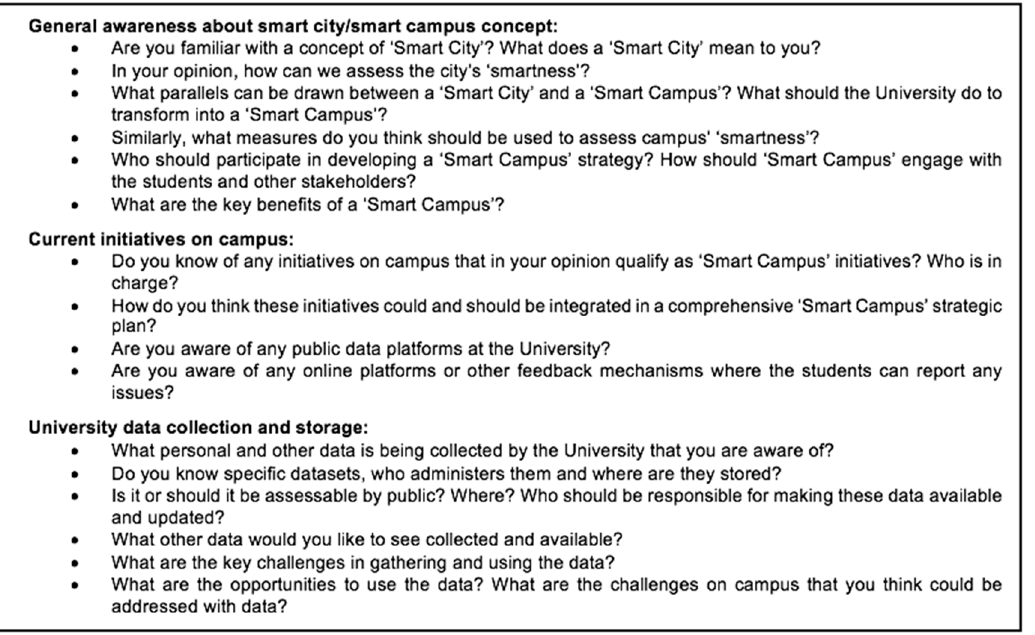
Figure 1. Questions of a semi-structured interview.